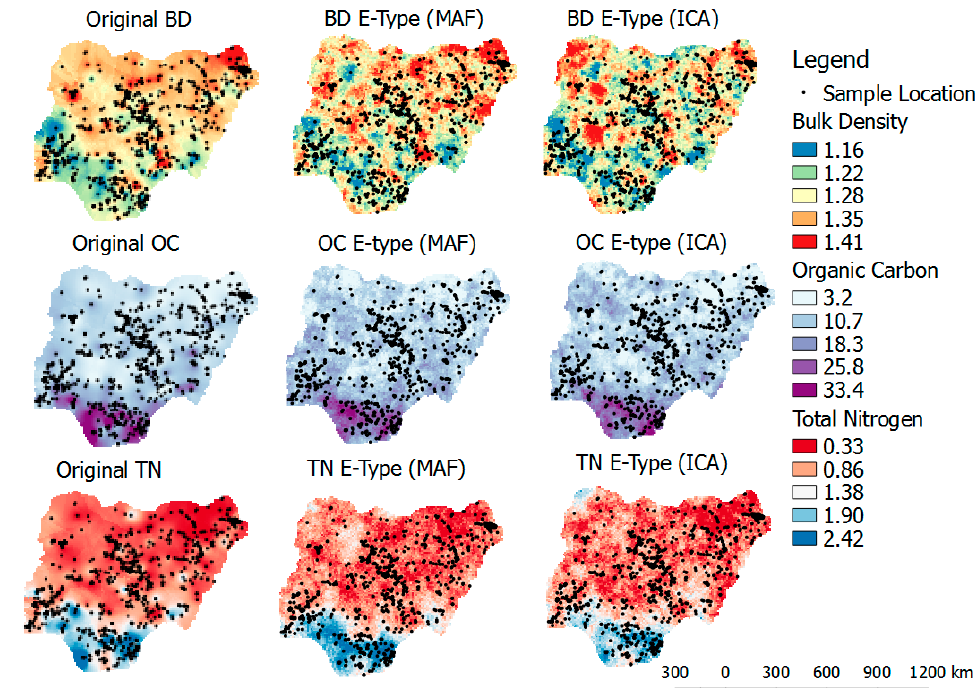
Figure 14. Original soil health indicators and simulations of the back-transformed simulated average realizations (E-type), using MAF (second column) and ICA (third column) (BD E-type = average of 100 realizations for bulk density (g/cm 3 ); OC E-type = average of 100 realizations for organic carbon (g/kg); TN E-type = average of 100 realizations for total nitrogen (g/kg)). ISPRS Int. J. Geo-Inf. 2020 , 9 , x FOR PEER REVIEW